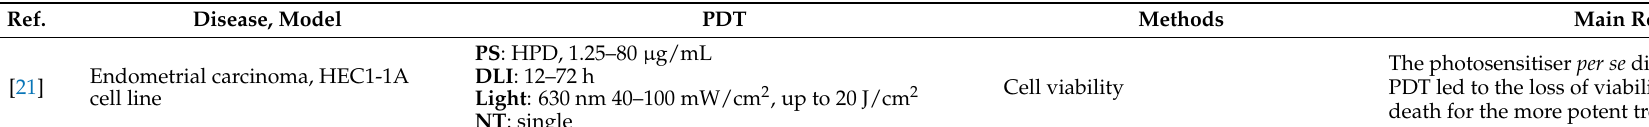
Table 1. In vitro